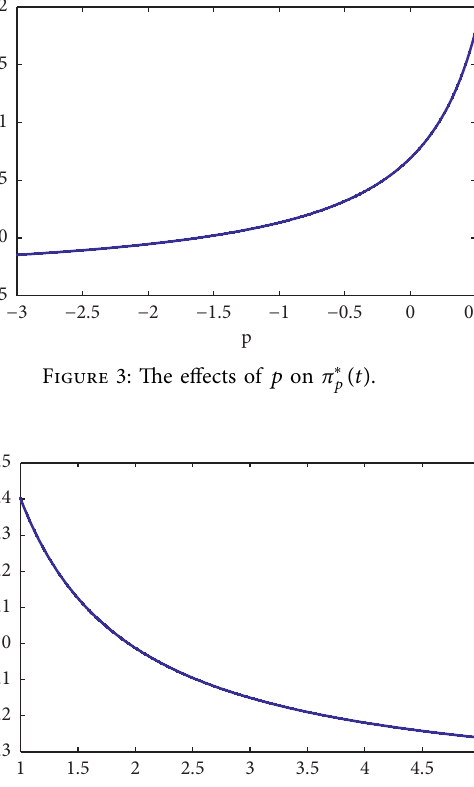
Figure 4: The effects of c on π ∗